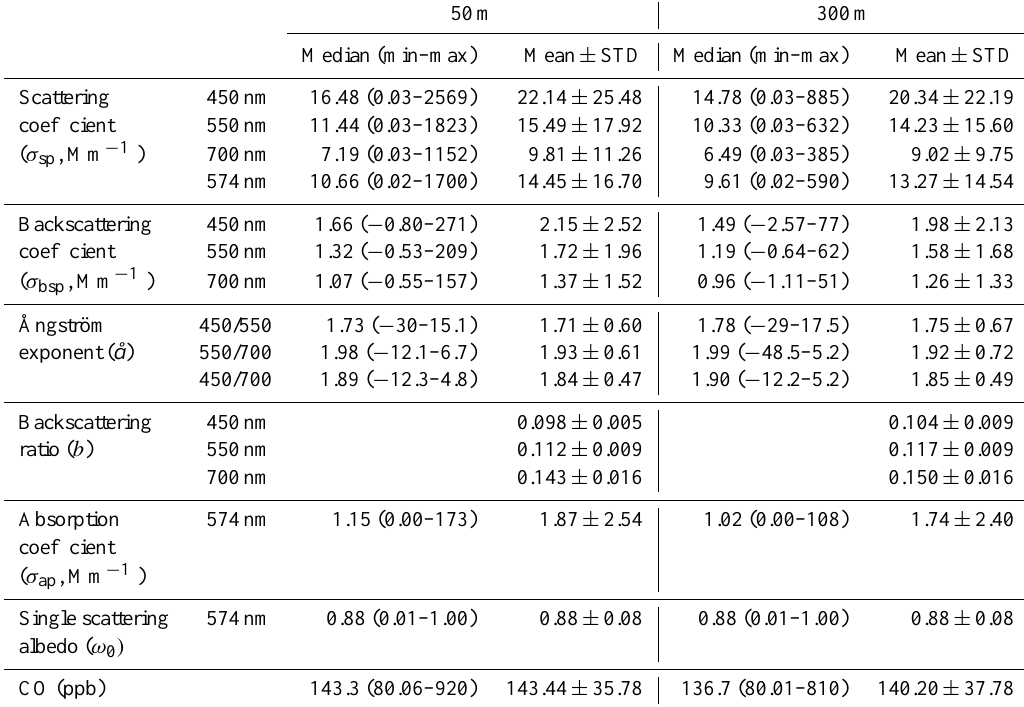
Table 1. Median and range, average and standard deviation of scattering coefficient, backscattering coefficient, Ångström exponent, backscat- tering ratio, absorption coefficient, single scattering albedo, and CO for 50m and 300m height levels at